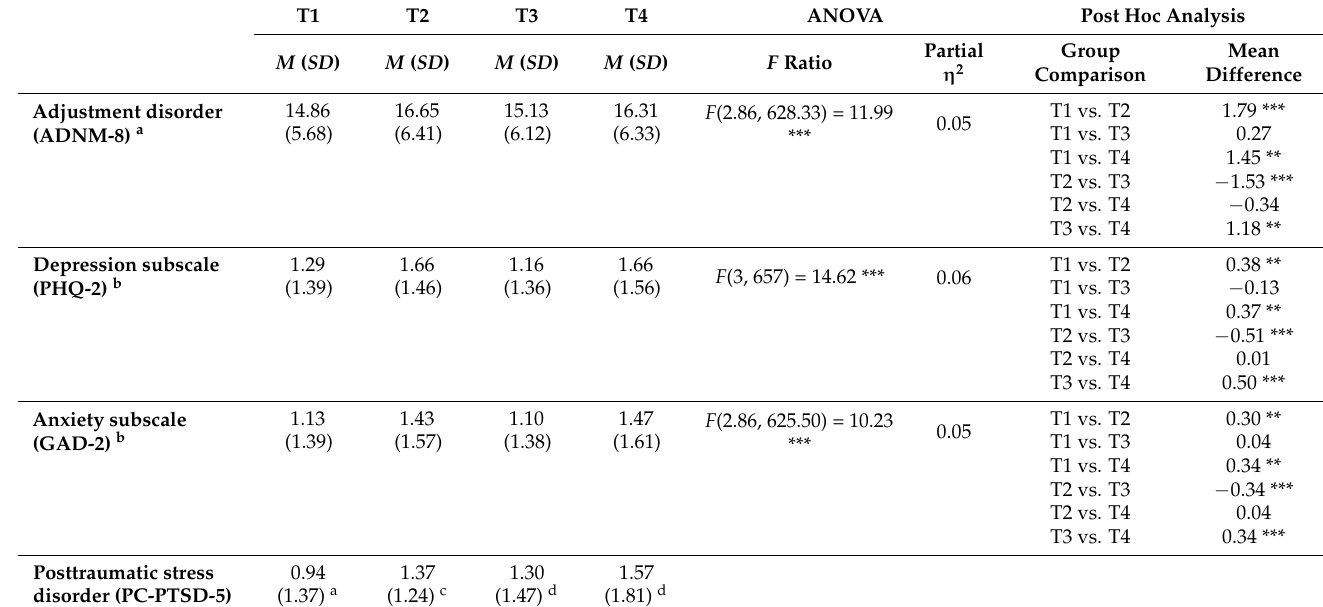
Table 5. Means, standard deviations, and repeated measures ANOVA statistics for mental health